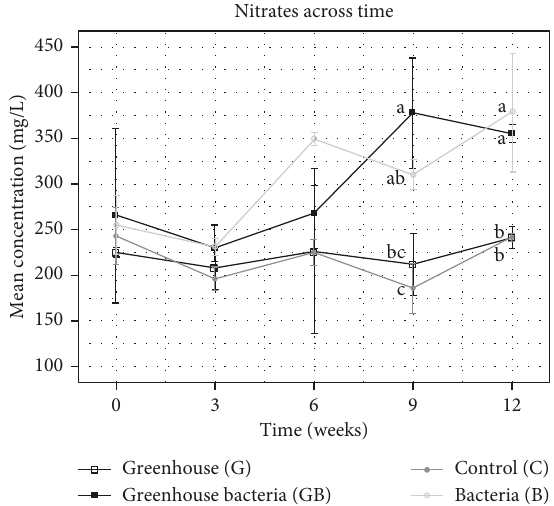
Figure 3: Ammonium concentrations per treatment across time. Means within a time measured followed by the same letter are not significantly different according to the Tukey–Kramer test or Nemenyi test in case of no normality.